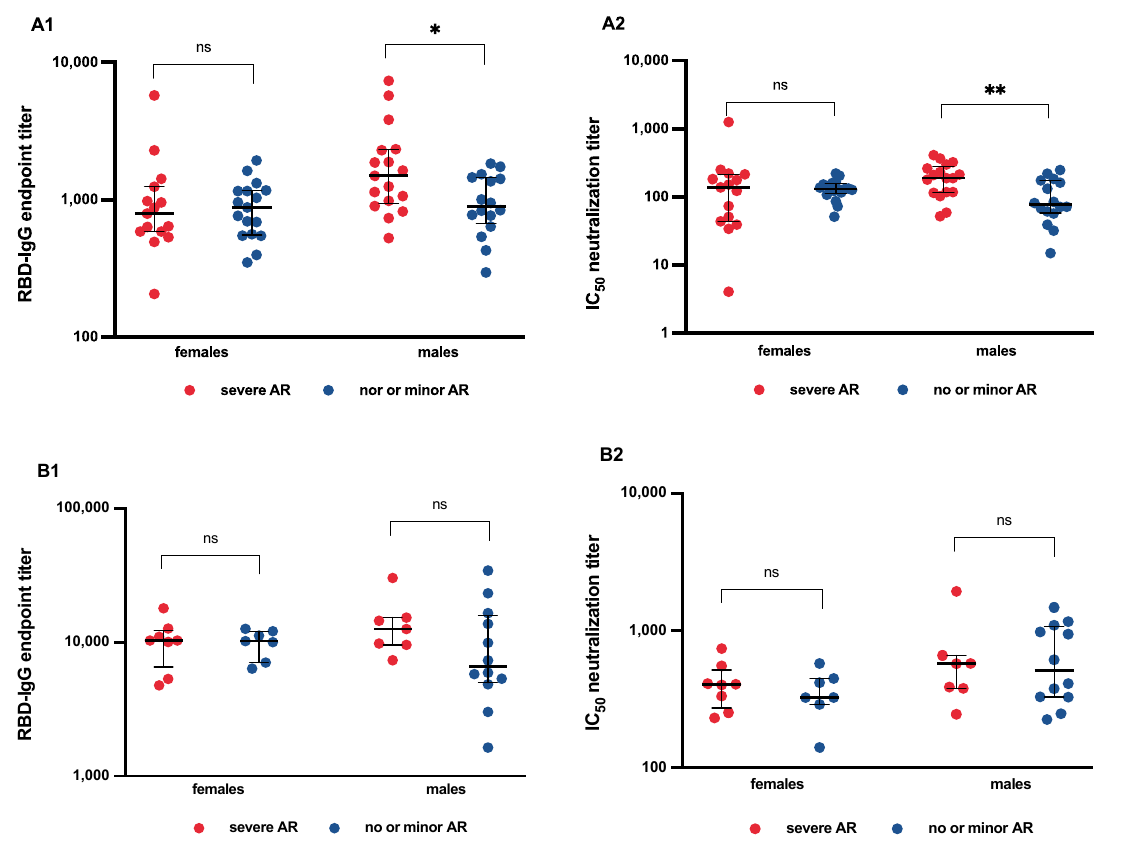
Figure 4. Association of immunogenicity and reactogenicity. Shown are antibody titers and neutralization capacity at median 26 weeks after second vaccination in 65 vaccinees of the initial reactogenicity groups ( A1 , A2 ) and at median 4 weeks after booster vaccination in 34 vaccinees with either severe adverse reactions or no or minor injection site symptoms after booster vaccination ( B1 , B2 ). Presented are individual IgG endpoint titers and median with interquartile range as measured by wild-type (WT) receptor-binding domain ( A ) and neutralization capacity ( B ) given as half maxi- mal inhibitory concentration (IC 50 ) as measured by WT pseudovirus assay. For statistical analysis, Mann–Whitney-U-Test was performed. AR = adverse reactions; ns = not significant. * p < 0.05; ** p <